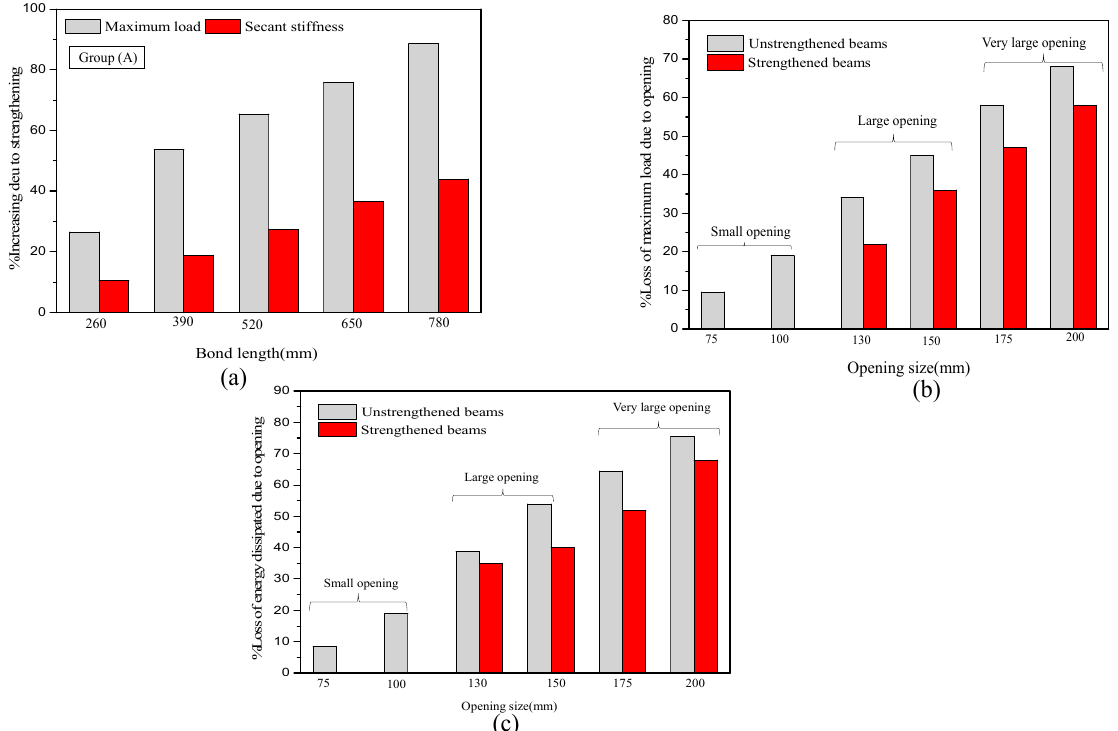
Figure 16. Effect of CFRP length and opening size on the performance of group A beams with respect to ( a ) secant stiffness, ( b ) maximum load and ( c ) energy dissipated at the ultimate state.